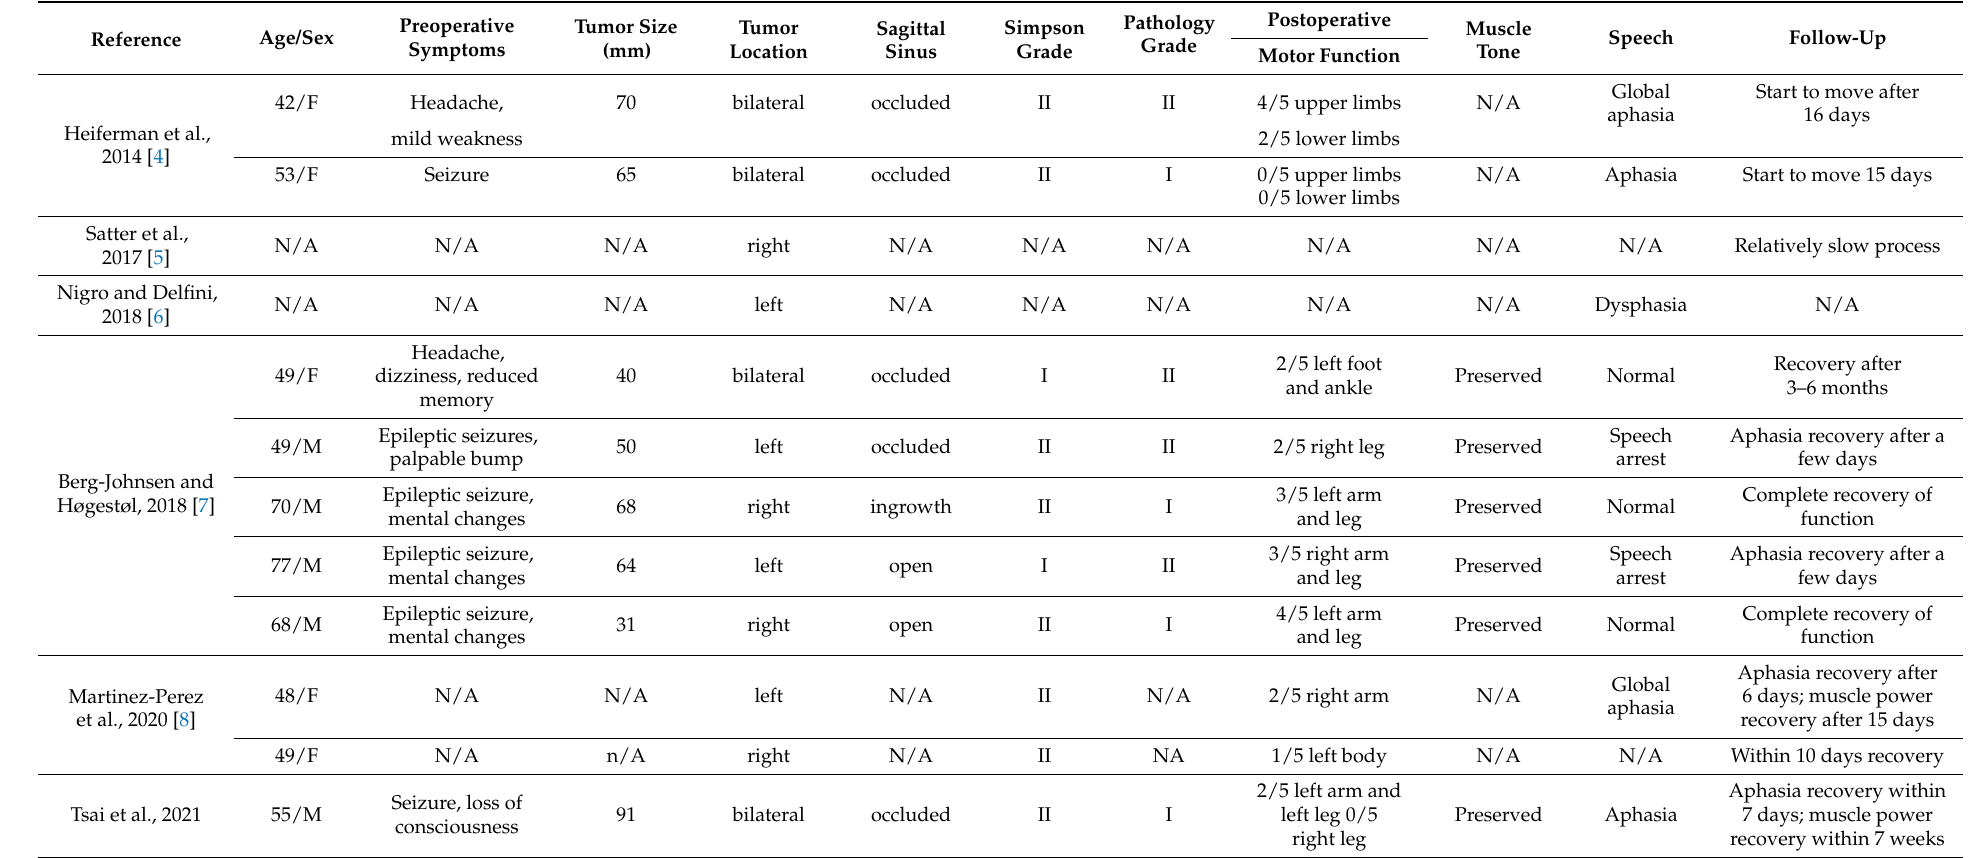
Table 1. Twelve cases of SMA syndrome in extra-axial